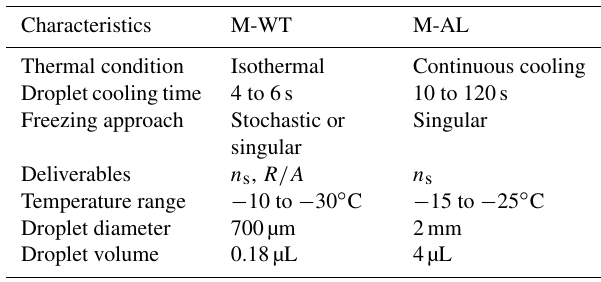
Table 2. Characteristics of the experiments conducted with the M- WT and